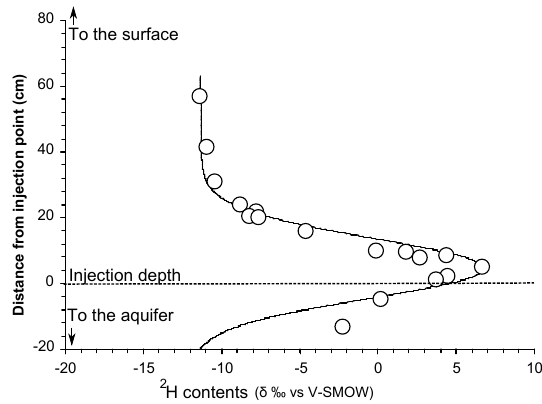
Fig. 3. Deuterium contents ( δ ‰ vs. V-SMOW) of soil water in function of the distance to the injection point 35 days after tracer injection. The curve corresponds to the best Hydrus 2D fit with steady-state water regime assumption with the soil parameters. ( 2 r =0.0304, 2 s , =0.287, α =0.0304cm − 1 , K s =0.22cmmin − 1 , n =2.207 and a longitudinal dispersivity=8.15cm and Lateral dis- persivity